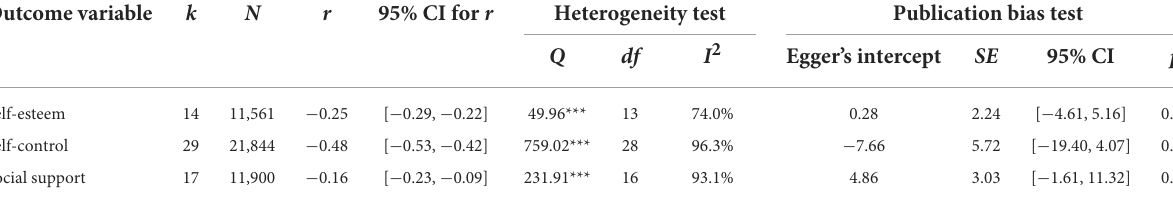
TABLE 2 Effect size and its heterogeneity test and publication bias